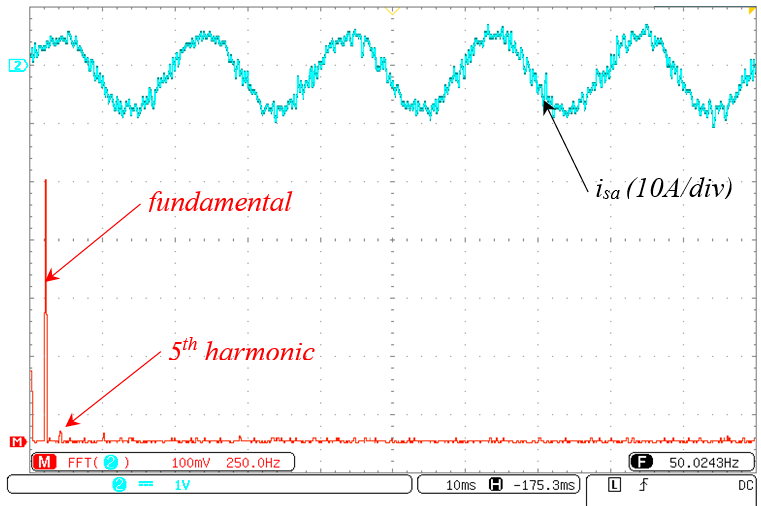
Figure 20. FFT analysis for supply current after connecting PV system.